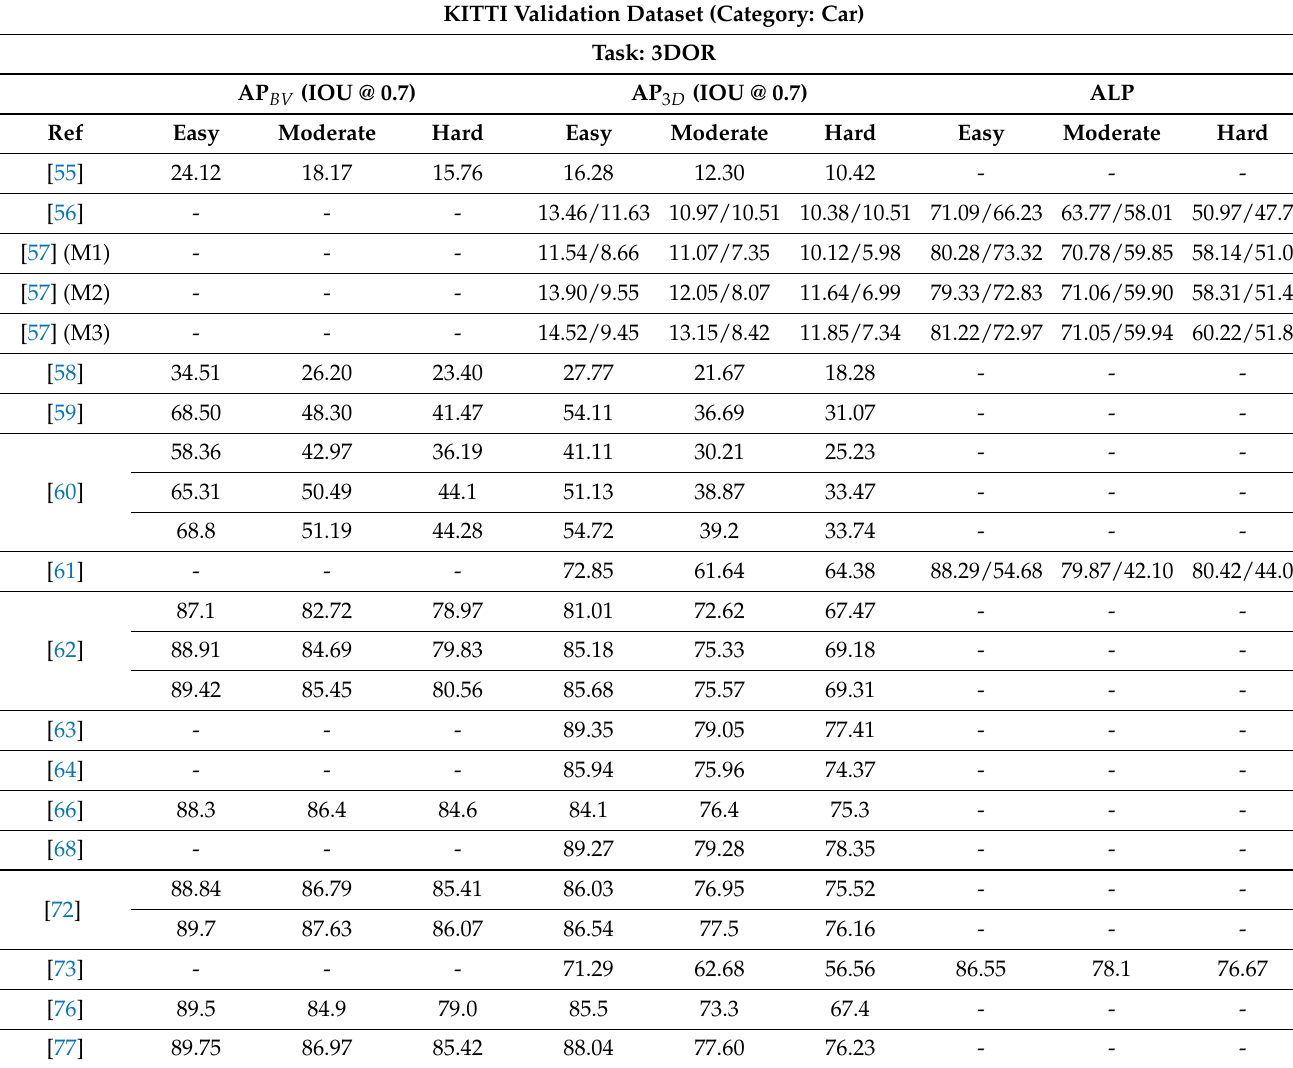
Table 21. Comparison of the Results on the KITTI Validation Dataset for the Car Category. KITTI Validation Dataset (Category: Car) Task: